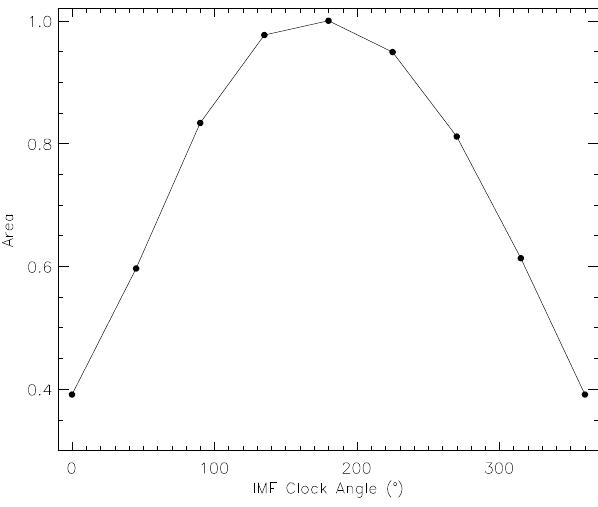
Figure 5. The CRW area as a function of the IMF clock angle, all other parameters are the same as that at the quiet time 6 July 2001, 12:00UT. The y axis has been